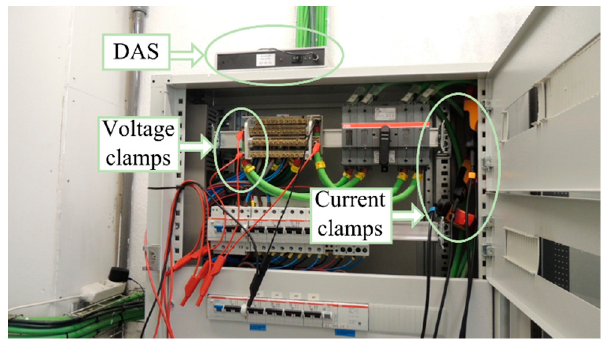
Figure 6. DAS installation at a secondary board in the hospital.